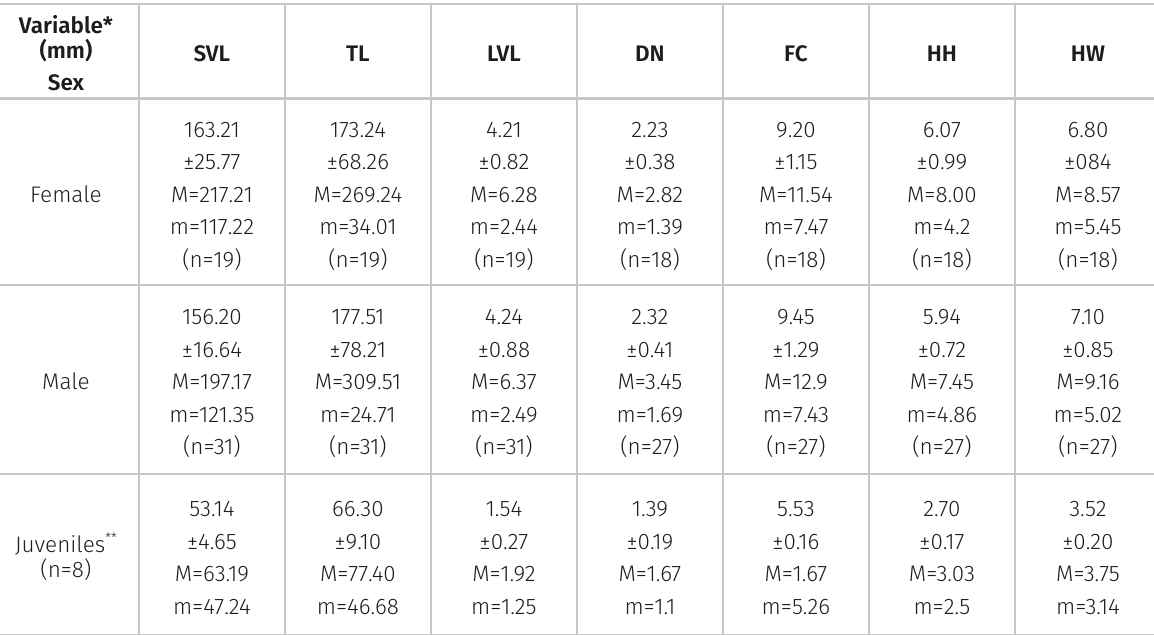
Table I. Means calculated for the snout-vent length (SVL), tail length (TL), length of the vestigial hind limbs (LVL), distance between nostrils (DN), face commissure (FC), head height (HH) and head width (HW) of the females, males and offspring of Ophiodes striatus belonging to the Coleção Herpetológica da Universidade Federal de Juiz de Fora, Minas Gerais - Reptiles (CHUFJF-Reptiles).